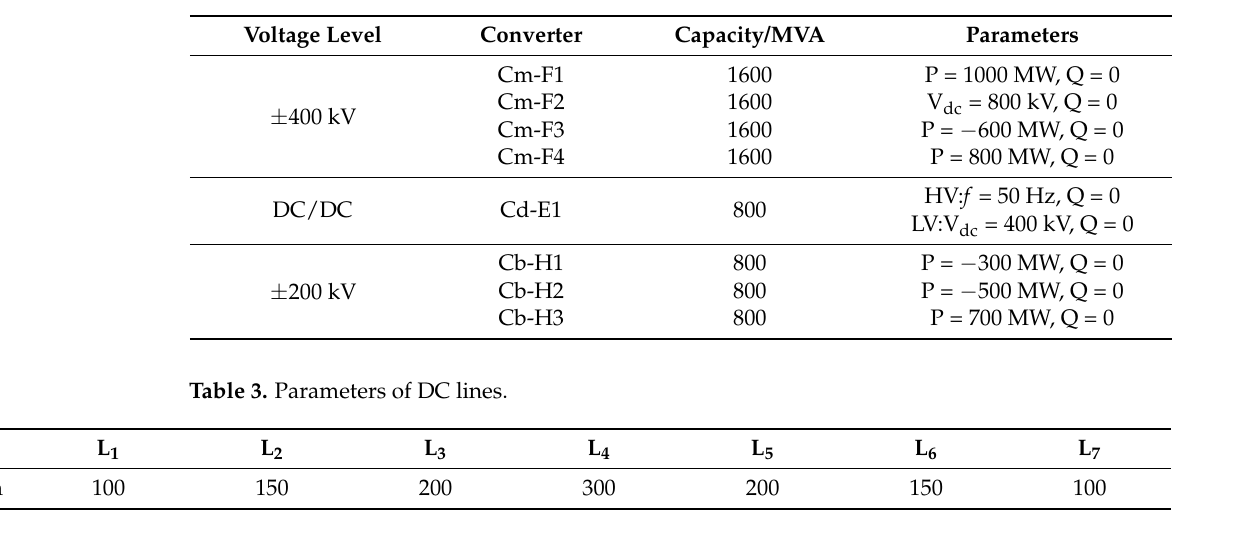
Table 2. Parameters of converter stations.